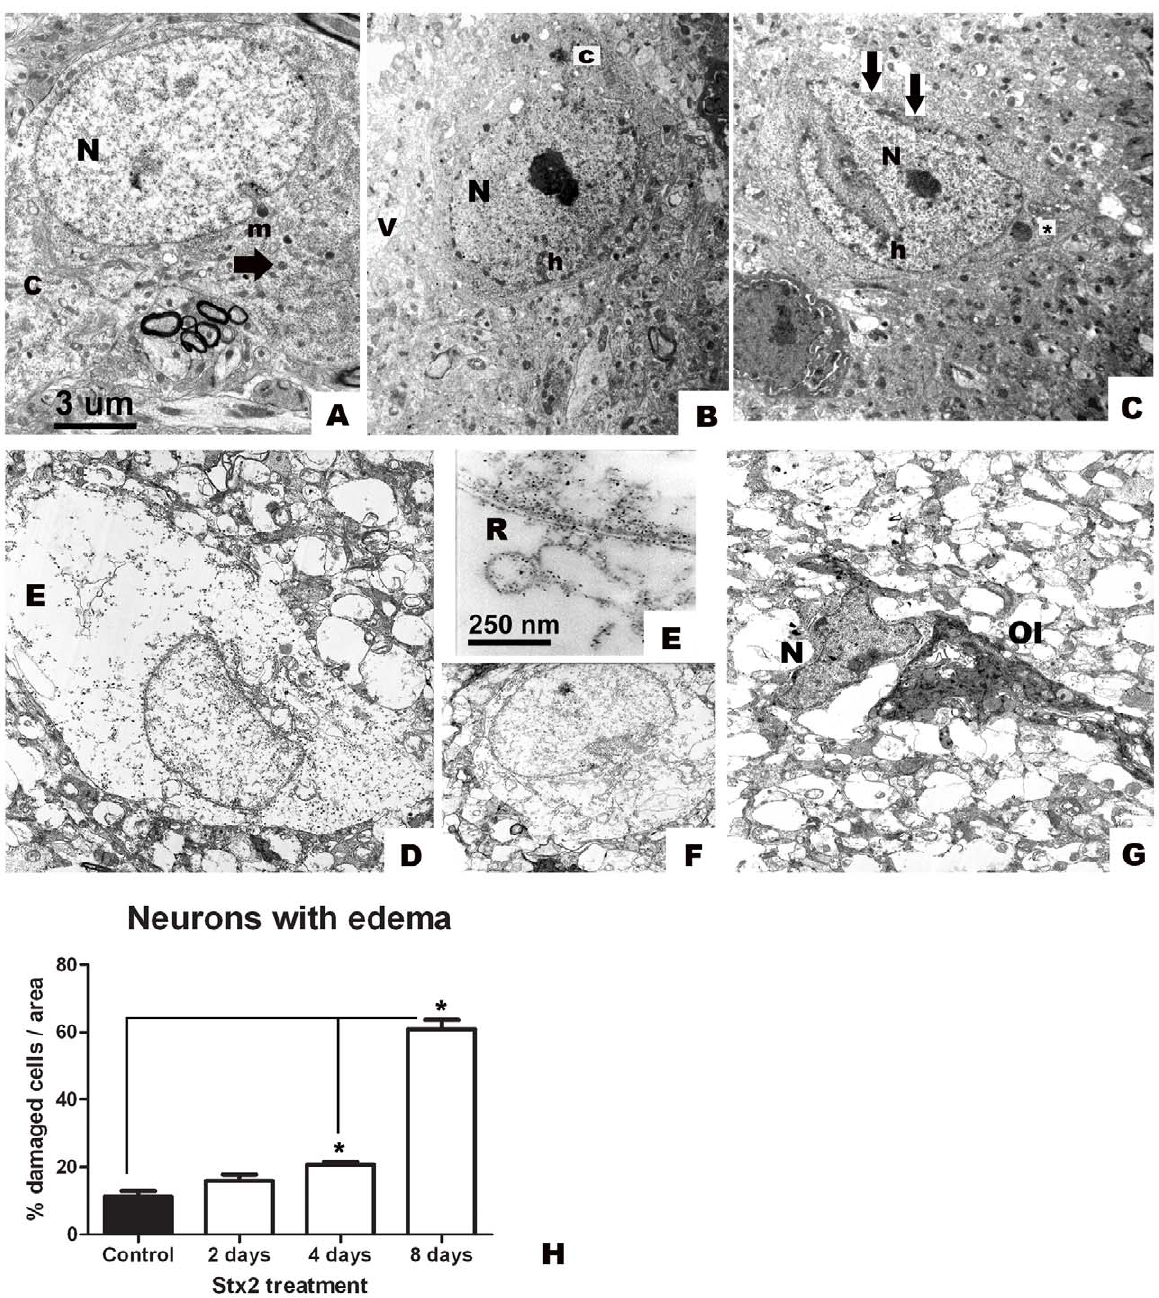
Figure 2. Intravenous administration of Stx2 causes neuronal damage. Conserved striatal neuron after i.v. vehicle (saline) administration (A); pale nucleus (N) and intact cytoplasm (c) and membranes (m); intact mitochondrion (arrow). After 2 days of treatment: vacuolated neuron with contrasted cytoplasm (c) and nucleus (N) (B); heterochromatin condensation (h). After 4 days: more contrasted nucleus (N) with increased heterochromatin (h) condensation and prominent indentation with loss of membranes (arrows) (C); vacuolated perinuclear mitochondrion (*) (C). Neuron with edema and loss of regular nuclear shape on day 8 (D). Disorganized endoplasmic reticulum (R) in the cytoplasm with edema (E) at higher magnification; loss of regular shape in the nucleus (F) of a neuron with edema (E); affected neuronal nucleus (N) with irregular shape and no apparent surrounded cytoplasm; (Ol, oligodendrocyte) (G). These features are absent in striatal neurons of the vehicle-treated group (A). Quantification of the percentage of damaged neurons with edema (H). Significant results are observed starting on day 4. Maximum number of neurons with edema in Stx2-treated mice observed on day 8 (*) (H). Results are expressed as a percentage of the total number of neurons in an area of 3721 m m 2 . Data are mean 6 SEM of 6–8 experiments (F and G). An asterisk denotes statistical significance, p , 0.05. The scale bar in A applies to micrographs B–D and F–G.